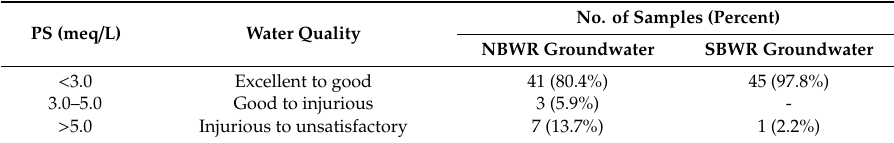
Table 6. The classifications of groundwater quality for irrigation based on the PS (potential salinity) [72]. No. of Samples (Percent) PS (meq / L) Water Quality NBWR Groundwater SBWR Groundwater < 3.0 Excellent to good 41 (80.4%) 45 (97.8%) 3.0–5.0 Good to injurious 3 (5.9%) - > 5.0 Injurious to unsatisfactory 7 (13.7%) 1 (2.2%)